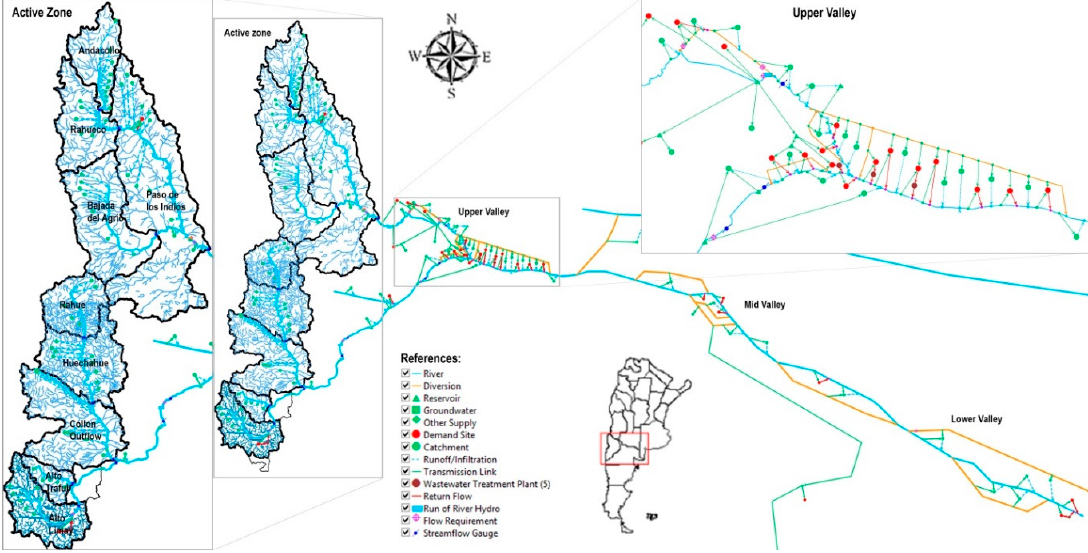
Figure 3. WEAP schematic of the Comahue region basins modeled in this study.